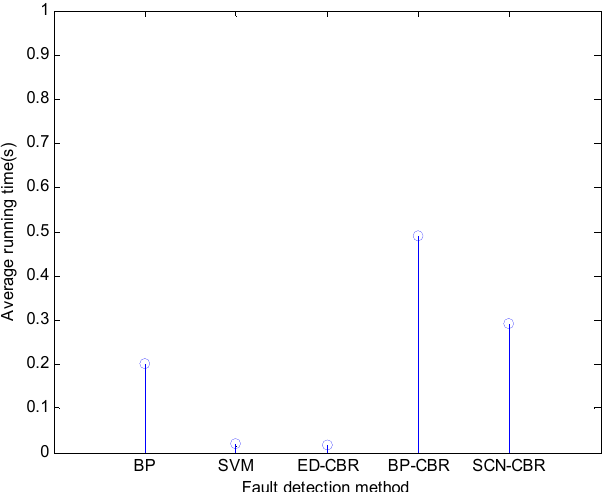
Figure 7. The running time of different methods for horizontal flue gas passage fault detection ( s ).